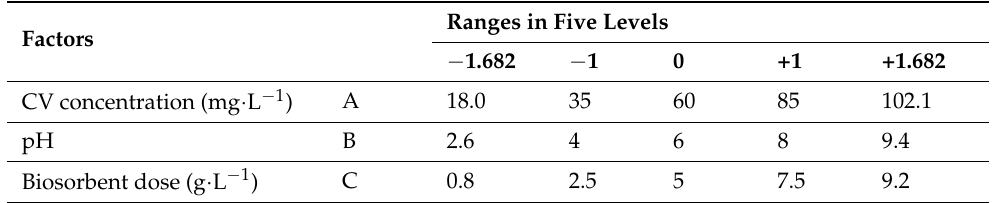
Table 1. Experimental range of independent factors and their levels.